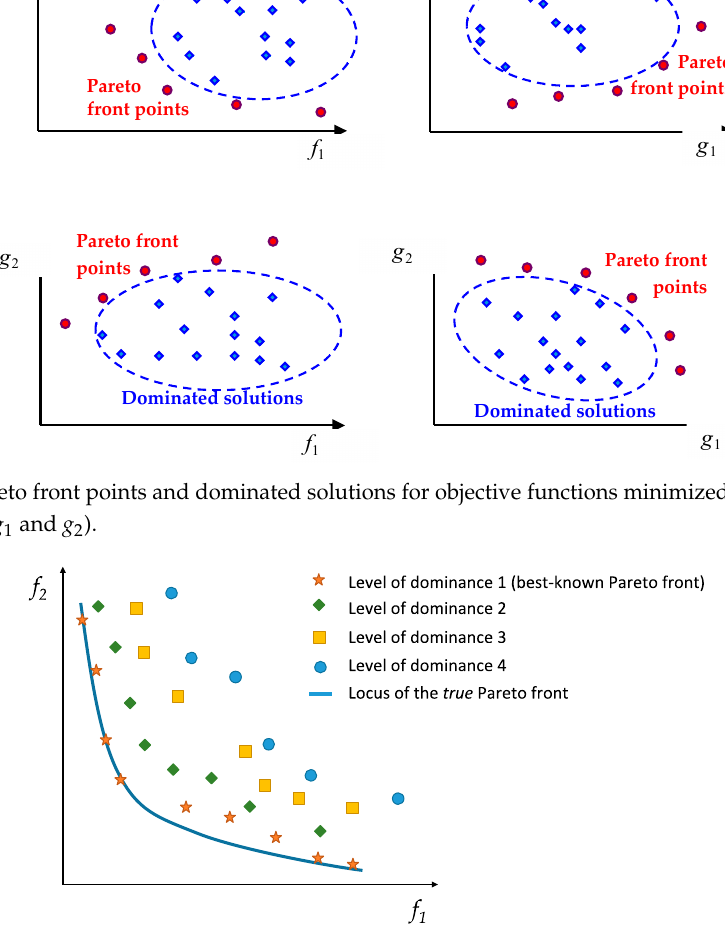
Figure 8. Levels of dominance. The functions f 1 and f 2 are minimized.